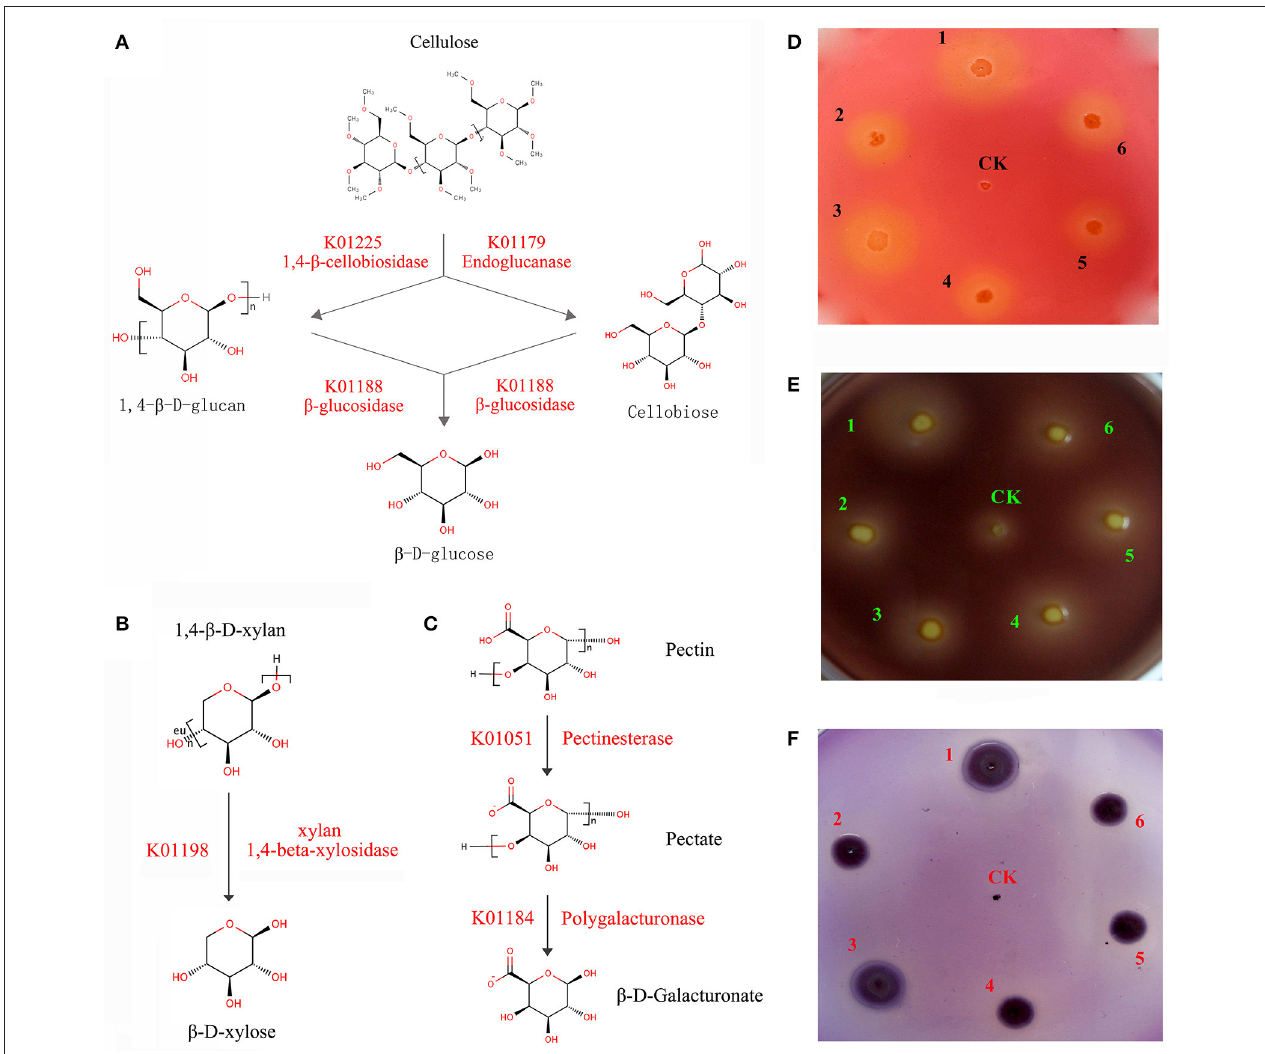
FIGURE 4 | P. xylostella gut bacteria-mediated metabolism of biomass. The schematic of biodegradation of caboxymethyl cellulose (CMC) (A) , xylan (B) , and pectin (C) with red words beside the arrow lines representing the degradation enzymes identified from the metagenome, and experimentally validated degradation of CMC (D) , pectin (E) , and xylan (F) with Escherichia coli used as negative control (CK). CMC, pectin and xylan degradation is detected by the formation of clearance zones around bacterial lawns, respectively, the Escherichia coli as negative control was cultured in the center of plates. The numbers of 1–6 in (D–F) represented that the six strains (DBMG1, DBMG2, DBMG3, DBMG4, DBMG5, and DBMG6) of CMC-, xylan-, and pectin-biodegrading bacteria isolated from P. xylostella gut. All these six strains were subjected to the genus of Enterobacter spp. The GenBank Accession Numbers: KT957438, KT957439, KT957440, KT957441, KT957442, and KT957443 were corresponding to the above strains of DBMG1, DBMG2, DBMG3, DBMG4, DBMG5, and DBMG6, respectively. The clearance zones in the plates (D–F) produced by the six strains indicated that the ability of biomass degrading.